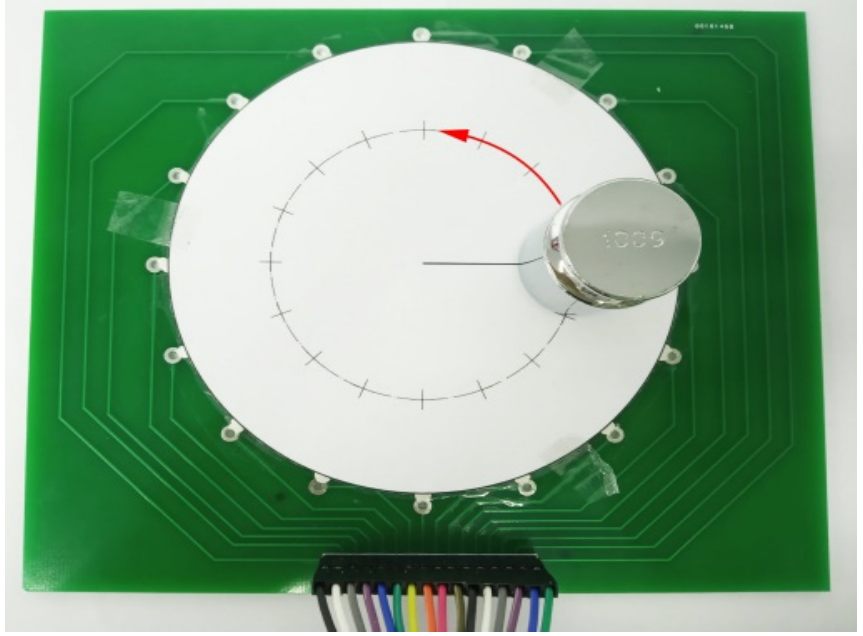
Figure 15. Setup to detect the sensitivity in circular direction.